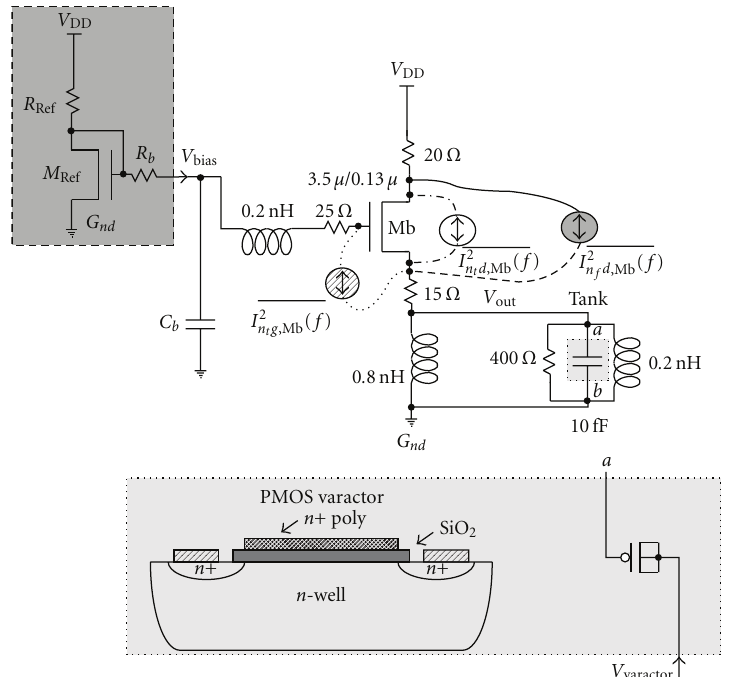
Figure 8: A practical noise inserted CMOS negative resistance bu ff er cell with component values, bias circuit, and varactor tuned tank.